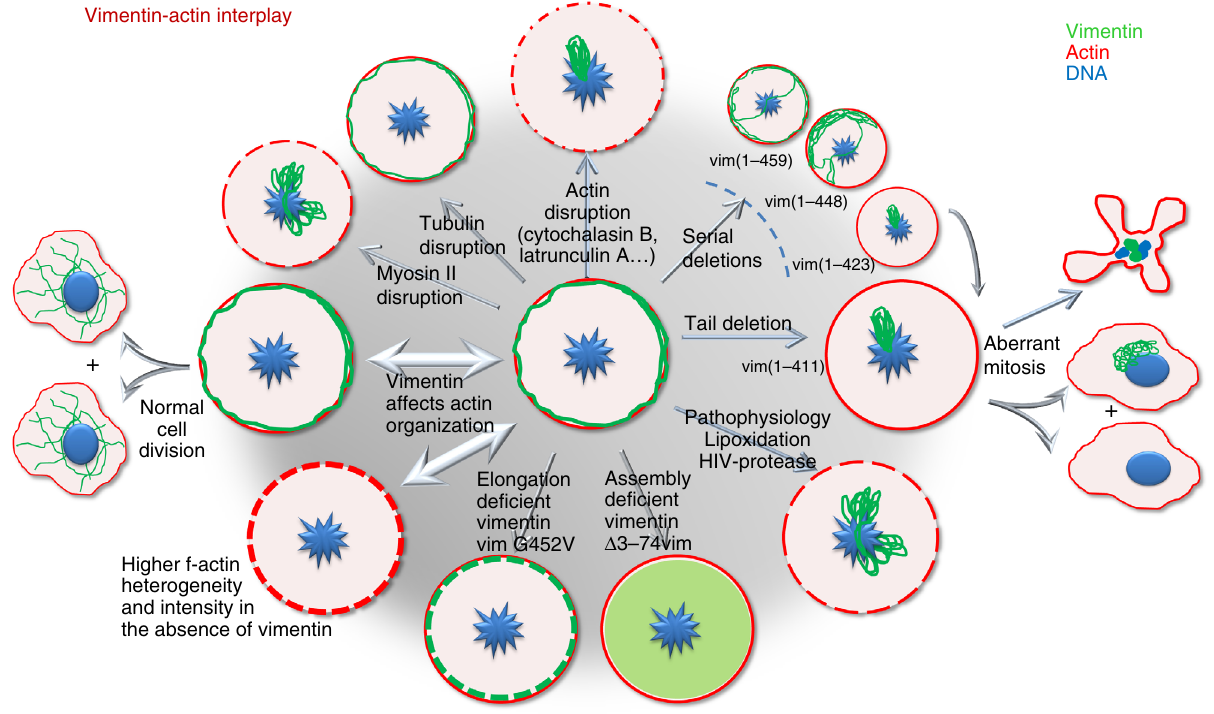
Fig. 9 Schematic representation of the interplay between vimentin and the actin cortex in mitosis. In certain cell types in which vimentin fi laments persist in mitosis (cell at the center of the fi gure), vimentin localizes to the actin cortex in mitosis, intertwining with cortical actin. This leads to normal mitosis, with nearly even distribution of vimentin between the two daughter cells (left). The tail segment of vimentin is required for this reorganization and normal mitosis, since vimentin distribution is progressively altered upon serial tail deletions yielding proteins spanning residues 1-459, 1-448, or 1-423, as indicated. Deletion of the whole tail segment, as in vimentin(1-411) precludes peripheral redistribution, and leads to interference with the mitotic apparatus and aberrant mitosis, with mitotic catastrophes or asymmetric partitions (right). Certain pathophysiological situations, including lipoxidation and expression of HIV-protease, mimic the distribution of tailless vimentin and impair vimentin association with the cell cortex in mitosis. A certain degree of assembly, but not the formation of full fi laments, appears necessary for vimentin cortical association, since soluble vimentin constructs are diffuse and do not associate with the cell cortex, whereas elongation de fi cient mutants lead to peripheral particles. Comparison of vimentin-positive and vimentin- negative cells unveils that the presence of vimentin at the actin cortex in mitosis affects actin organization, in fl uencing the heterogeneity and distribution of